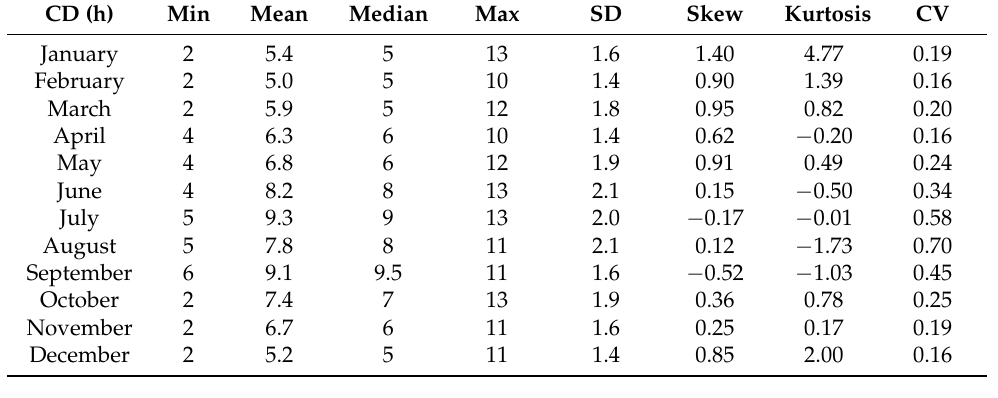
Table 1. Average statistical properties of monthly CD values for the stations. SD is an abbreviation for standard deviation and CV for coefficient of variation (the ratio of the standard deviation to the mean) and h for hours.